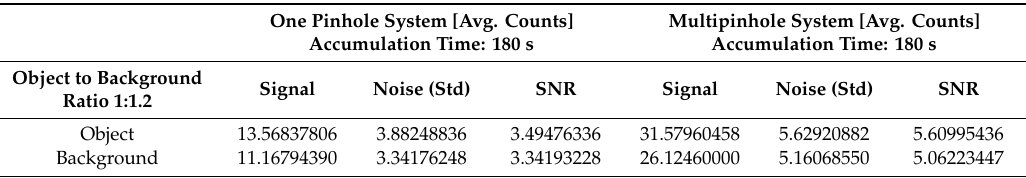
Figure 4. Simulation of the designed setup: The three 1-D pinhole arrays (space and frequency domains); ( a ) F1 is the filter related to the first pinhole array; ( b ) F2 is the filter related to the second pinhole array; ( c ) F3 is the filter related to the last pinhole array; ( d ) The sum of the three filters (top red) as compared to a single pinhole (top blue). The straight green line is the maximum level of the one pinhole reference level. Table 1. Calculated simulation results—signal to noise ratio (SNR): SNR improvement comparison showing noise counts for equal signal counts in the two systems. Note that the noise in the single √ pinhole system is larger by factor of 2.333 in comparison to noise in the 1,2,3 pinhole array